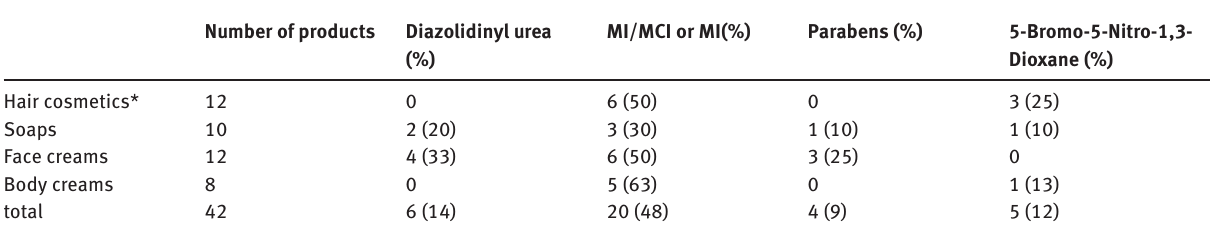
Table 2 . Preservatives most commonly present in investigated Lithuanian cosmetics according to labelling**, in numbers and